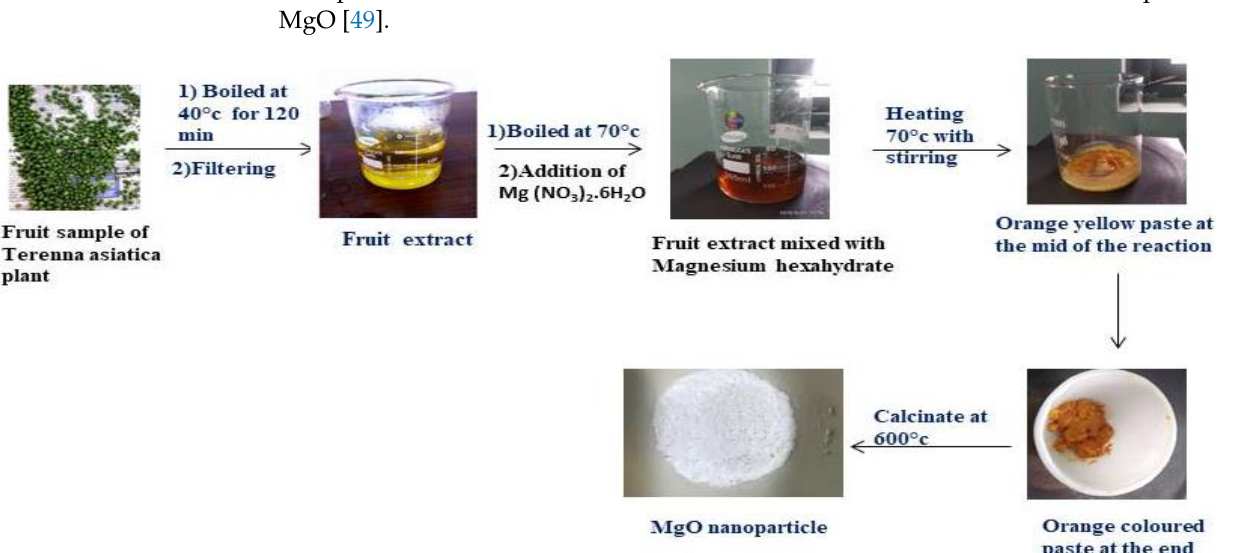
Figure 10. Extraction and processing scheme of Terenna asiatica plant fruit sample and preparation of biofunctionalized MgO nanoparticle.